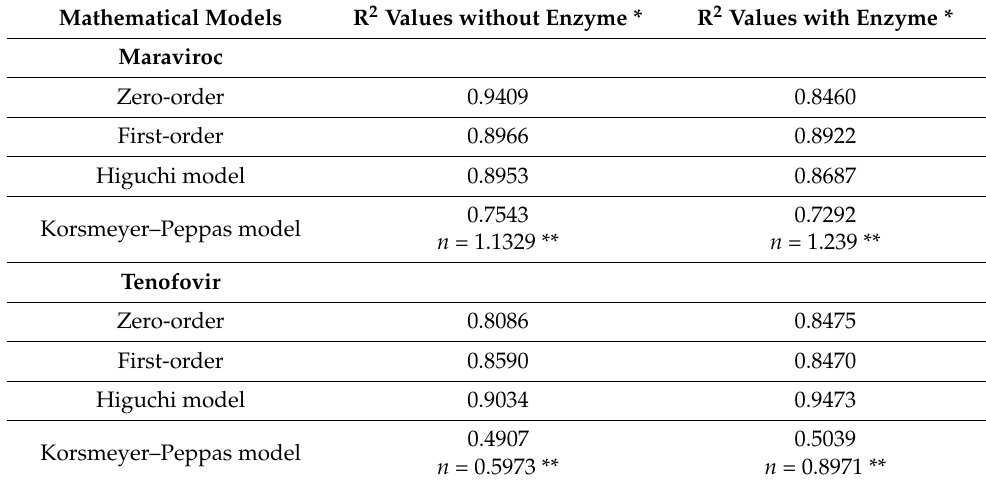
Figure 2: (A) Korsmeyer-peppas model kinetic release of tenofovir from microspheres. (B) Korsmeyer-peppas model kinetic release for tenofovir from microspheres facilitated with enzymes